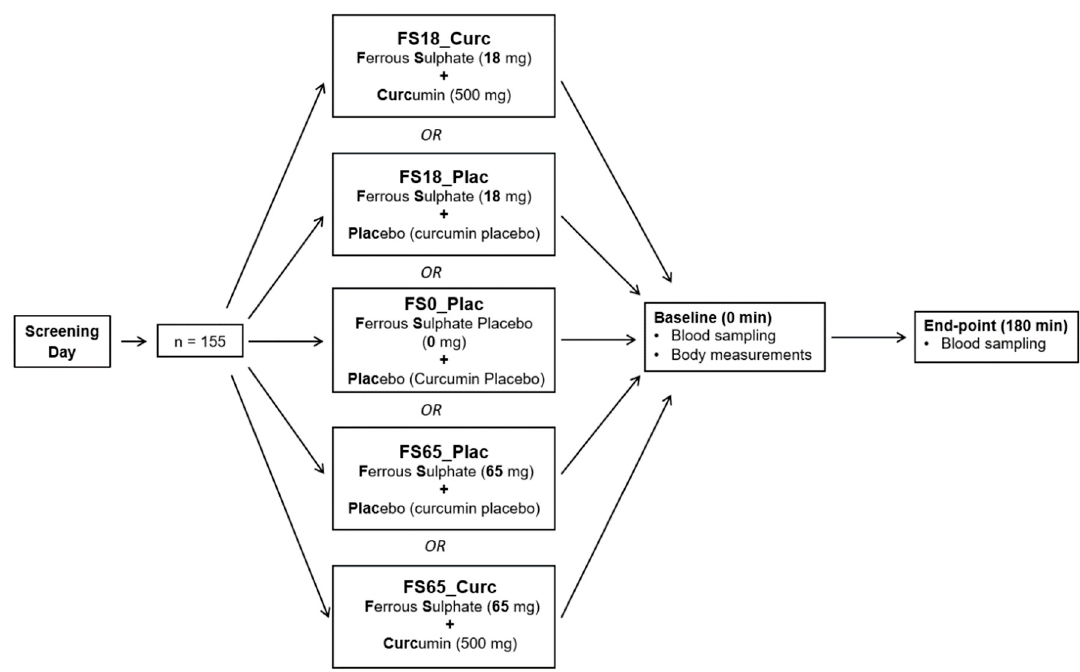
Figure 1. Study design. Random allocation to treatment groups post safety screening ( n = 31/group). At baseline (0 min), both body measurements and blood samples were collected. At end-point (180 min), only blood samples were collected.